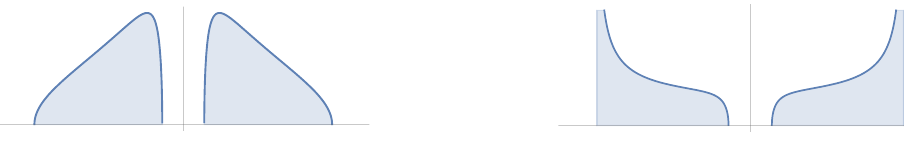
Figure 5 . Pro(cid:12)le of the spectral density when b = | ϕ | (left) and for a → | ϕ | (right). Eq. (4.30) can be used to generate series expansions of the free energy in di(cid:11)erent limits of regime II, as the bulk thermodynmical limit and the double light-cone limit, but this task is beyond the scope of this paper. Below I will only check that the limit σ/m (cid:29) 1 of (4.30) along the line σ = 0 indeed reproduces the large m asymptotics of the expression (2.9) for the double light-like